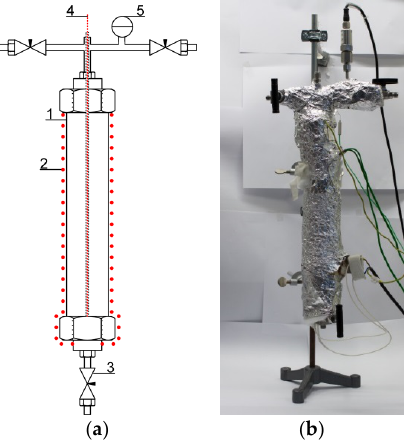
Figure 1. ( a ) Scheme of the reactor including stainless steel tube (1), electrical heating wire (2), needle valve (3), thermocouple (4) and pressure sensor (5); and ( b ) reactor in the lab.